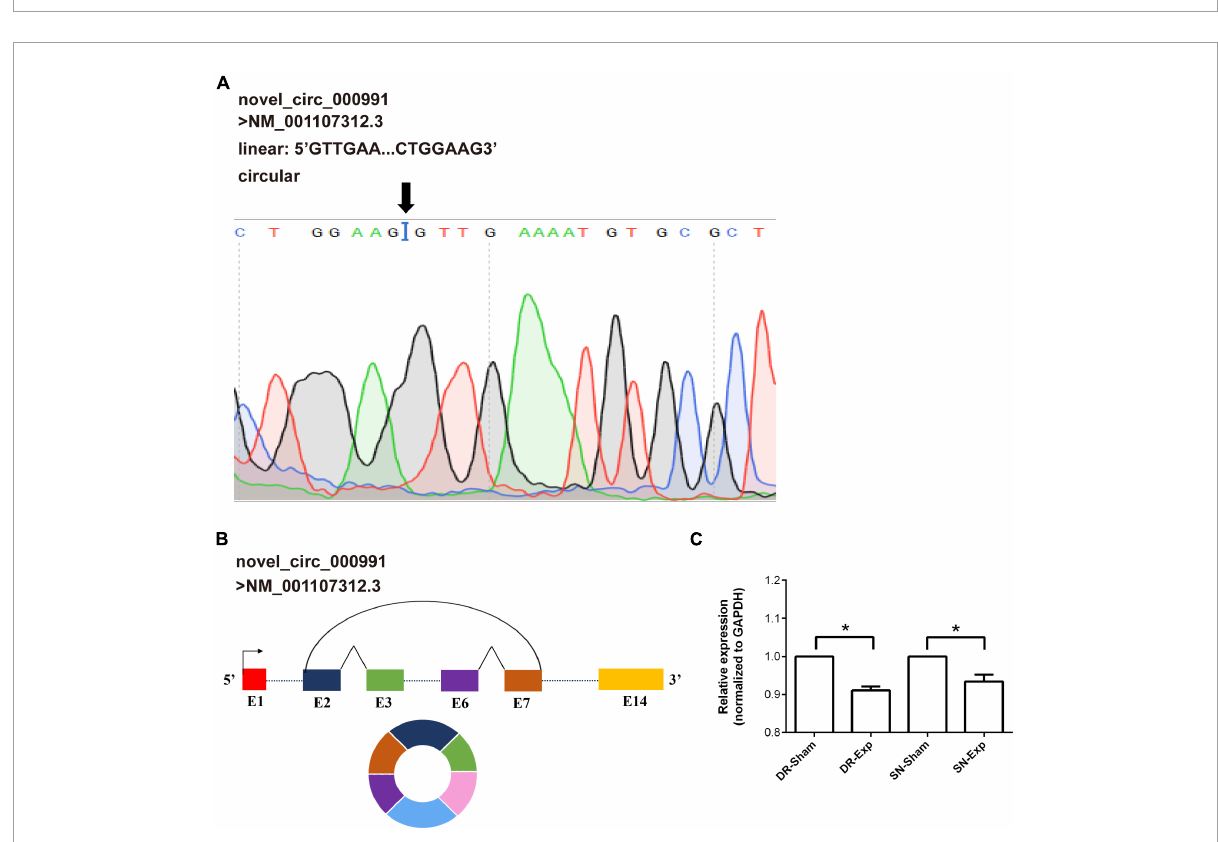
FIGURE4 Validation of the characterization and expression of circular RNA novel_circ_000991. (A) Determination of novel_circ_000991 by Sanger sequencing. Black arrow indicates the site of back-splicing. (B) Schematic representation of the genomic locus of novel_circ_000991 in its host gene Mtmr7 (NM_001107312.3). (C) Relative expression levels of novel_circ_000991 after rat central and peripheral axon injuries. Data are summarized from 3 experiments and presented as mean with SEM. * P -value <